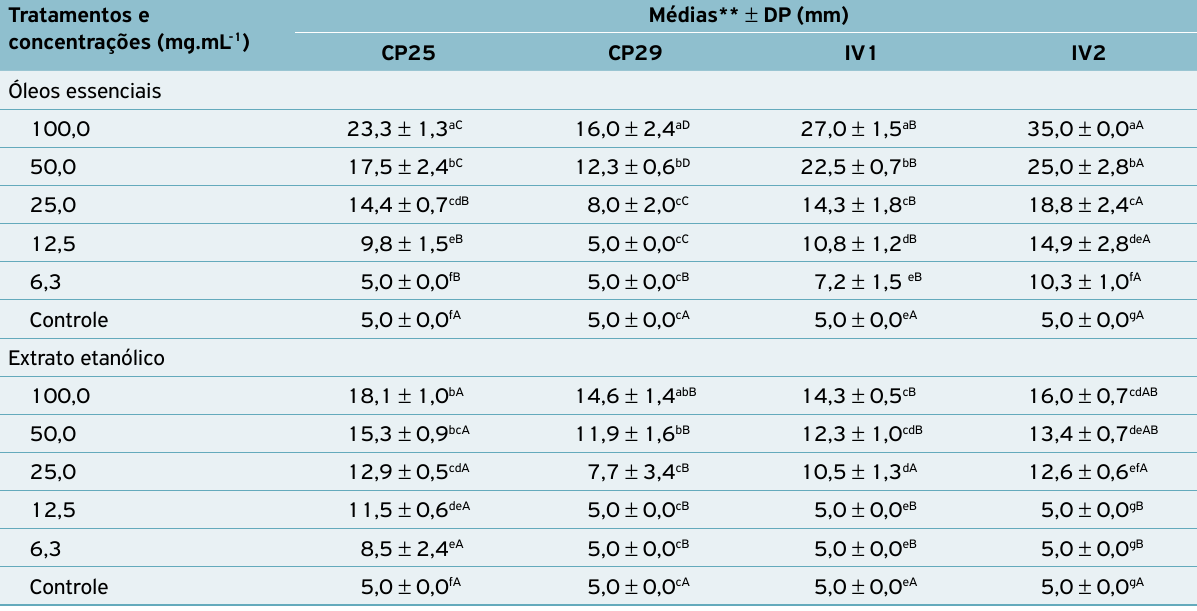
essencial e do extrato etanólico de Alpinia